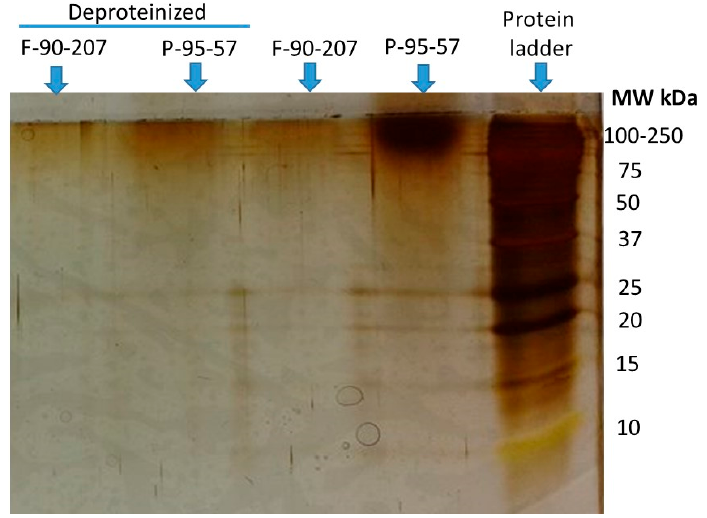
Figure 7. Identification of proteins before and after deproteinization of chitosan. Samples are P-95-57 (powder) and F-90-207 (flakes).